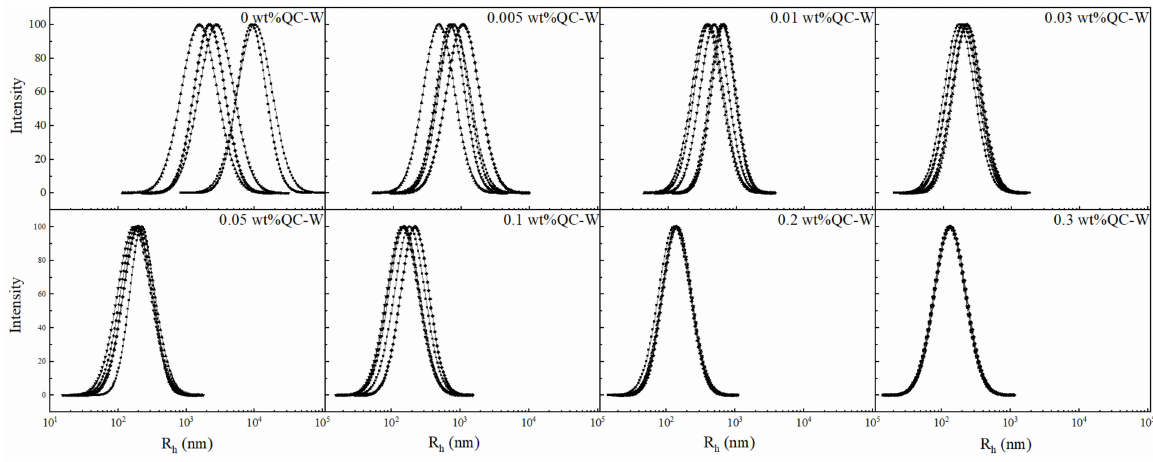
Figure 6. Influence of nano-SiO 2 on the hydrodynamic radius (R h ) of HPAM.